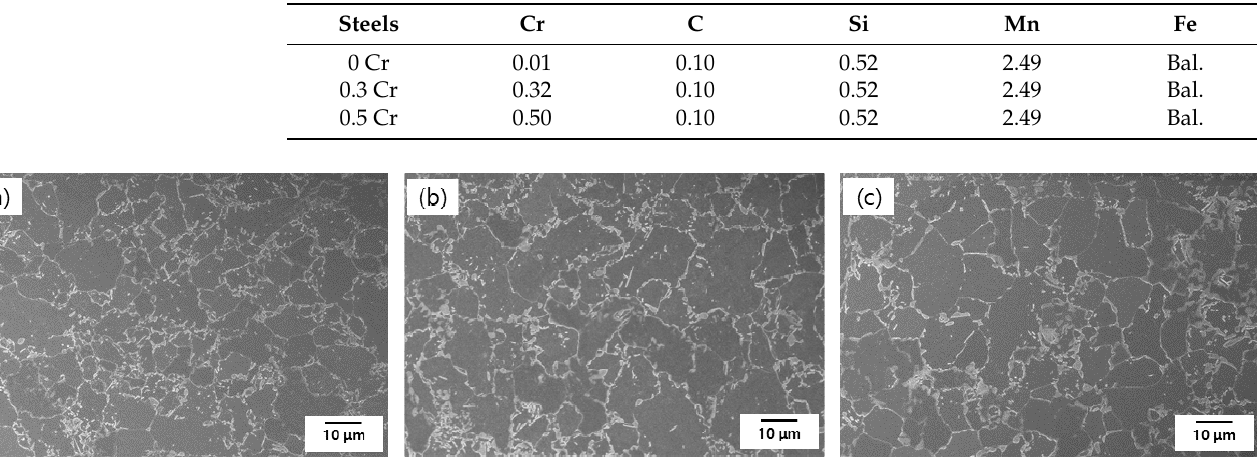
Figure 1. SEM images of the microstructure of ( a ) 0 Cr, ( b ) 0.3 Cr, and ( c ) 0.5 Cr, etched with 2% nital solution.